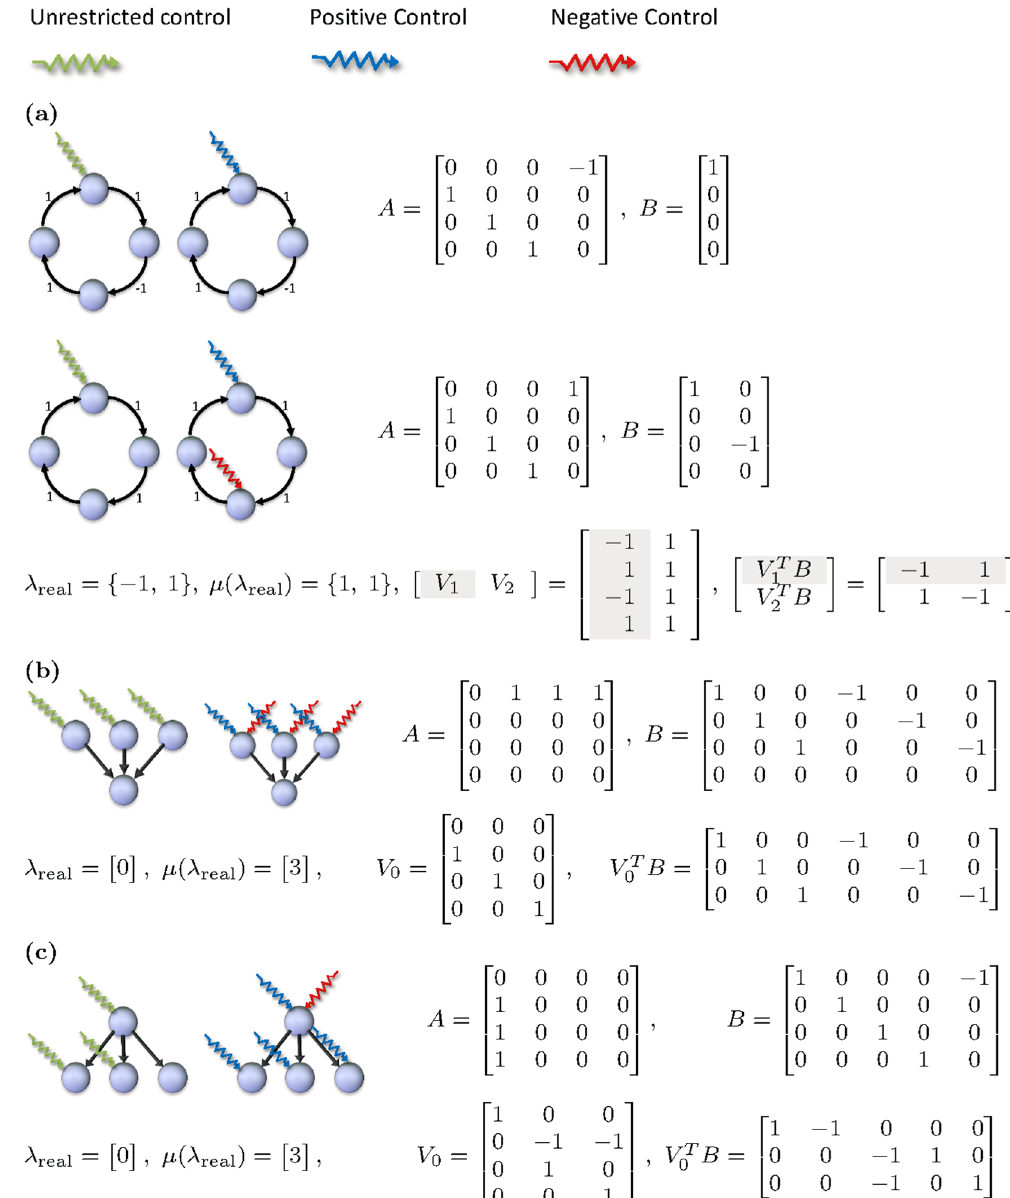
Figure 2. Examples of networks and control inputs that make them controllable. The system matrices A are shown with their real eigenvalues and left eigenvectors, as well as the minimal B that verifies condition ( ii ) of Theorem 1. ( a ) A circular network requires either one or two unilateral controls for controllability depending on the edge weights. When one edge weight is negative, all eigenvalues of A are complex and condition ( ii) of Theorem 1 is trivially met. When all edge weights are positive, there are two real eigenvalues with eigenspaces of dimension 1. In this case condition ( ii ) of Theorem 1 is equivalent to requiring that each of the row vectors V B T and V B T have both a positive and a negative entry. ( b ) A hub with incoming edges. The only real eigenvalue is 2 = 0 of geometric multiplicity 3. Three unrestricted or 6 unilateral controls are required for controllability. The λ 0 columns of V B T positively span  3 . ( c ) A hub with outgoing edges. 5 unilateral control inputs are enough to 0 achieve